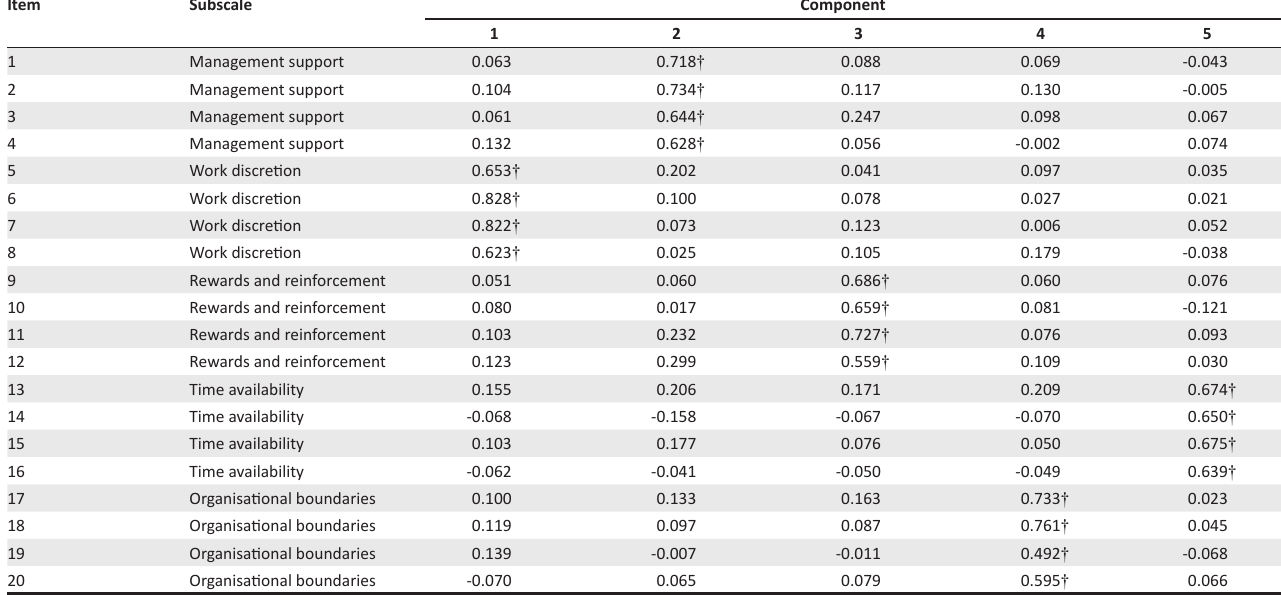
TABLE 5: Rotated component matrix of Corporate Entrepreneurship Assessment Instrument items.